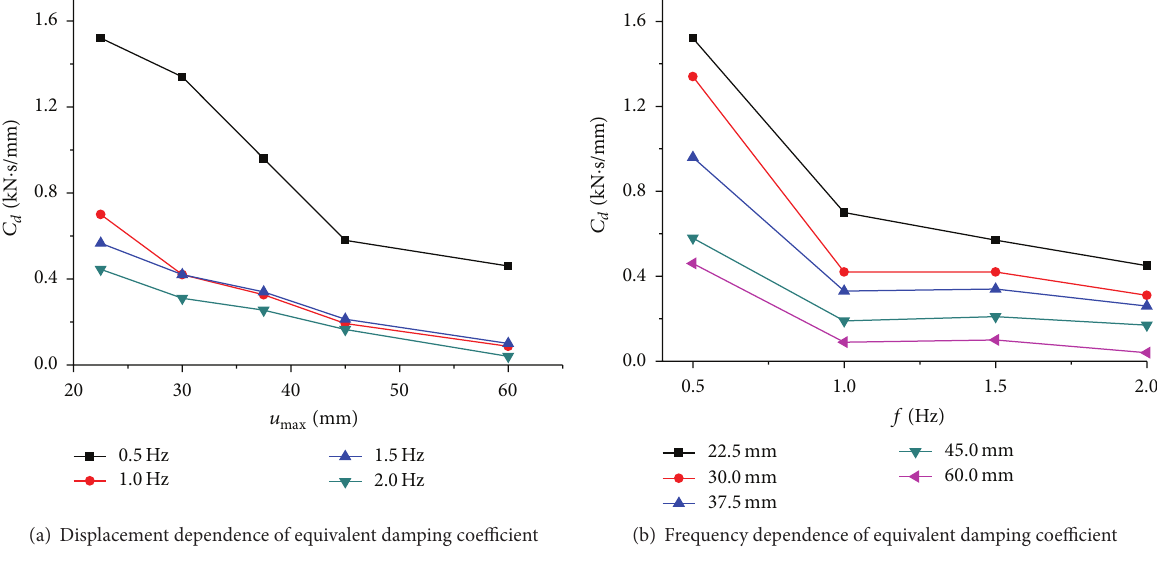
Figure 8: The equivalent damping coefficient.